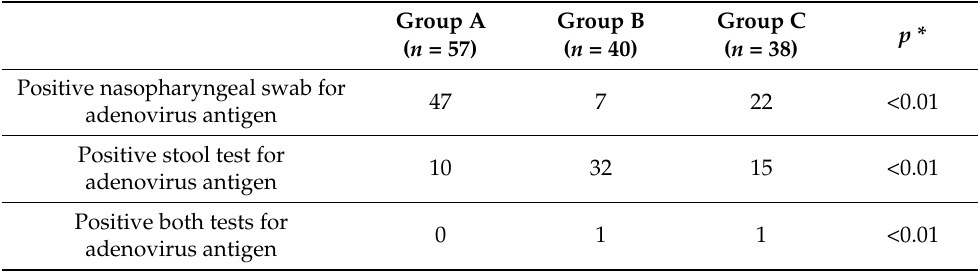
Table 2. Type of adenoviral tests used to confirm the diagnosis in